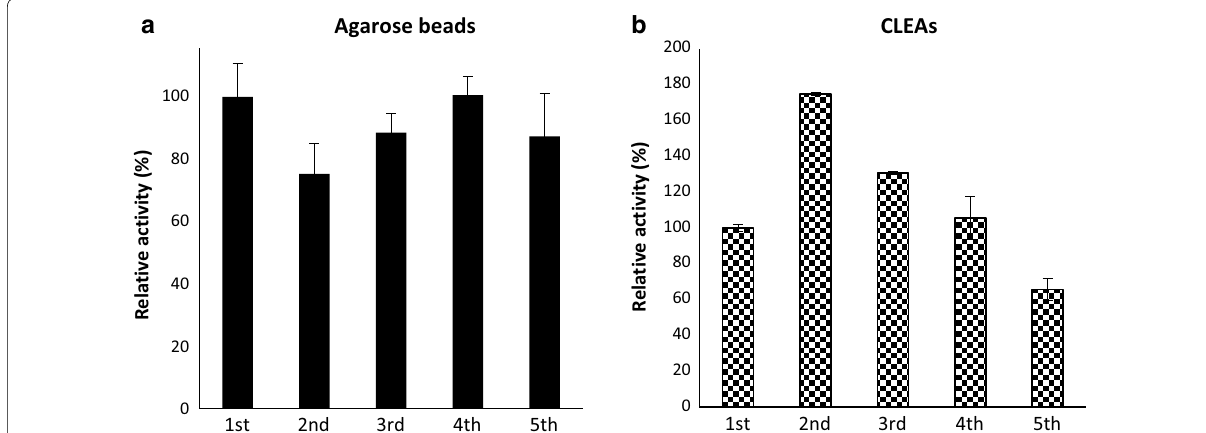
Fig. 5 The reusability of immobilized Sc Lac. The remaining activity of immobilized Sc Lac on agarose beads ( a ) or as CLEAs ( b ) was analyzed in sequential activity assays for five cycles using DMP as the